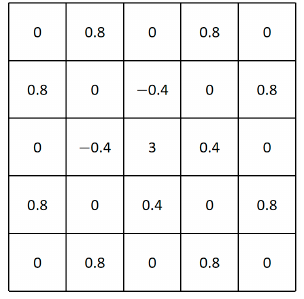
Figure 5. Different effects of different convolution kernels.